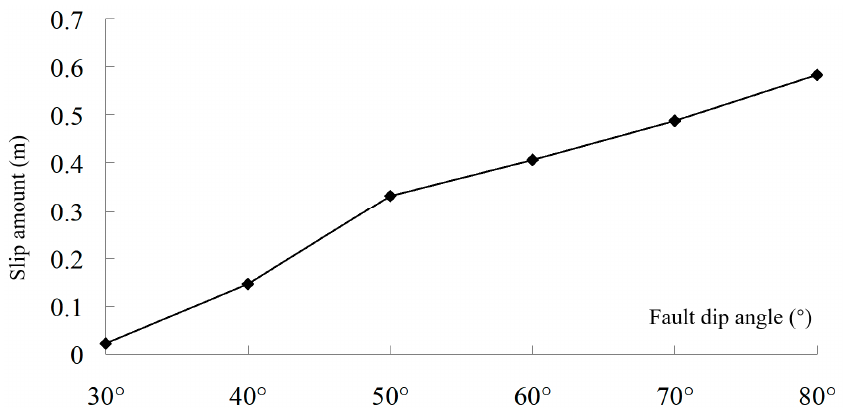
Figure 16. The shear stress distribution at the fault plane under various buried depths of the upper boundary of fault.